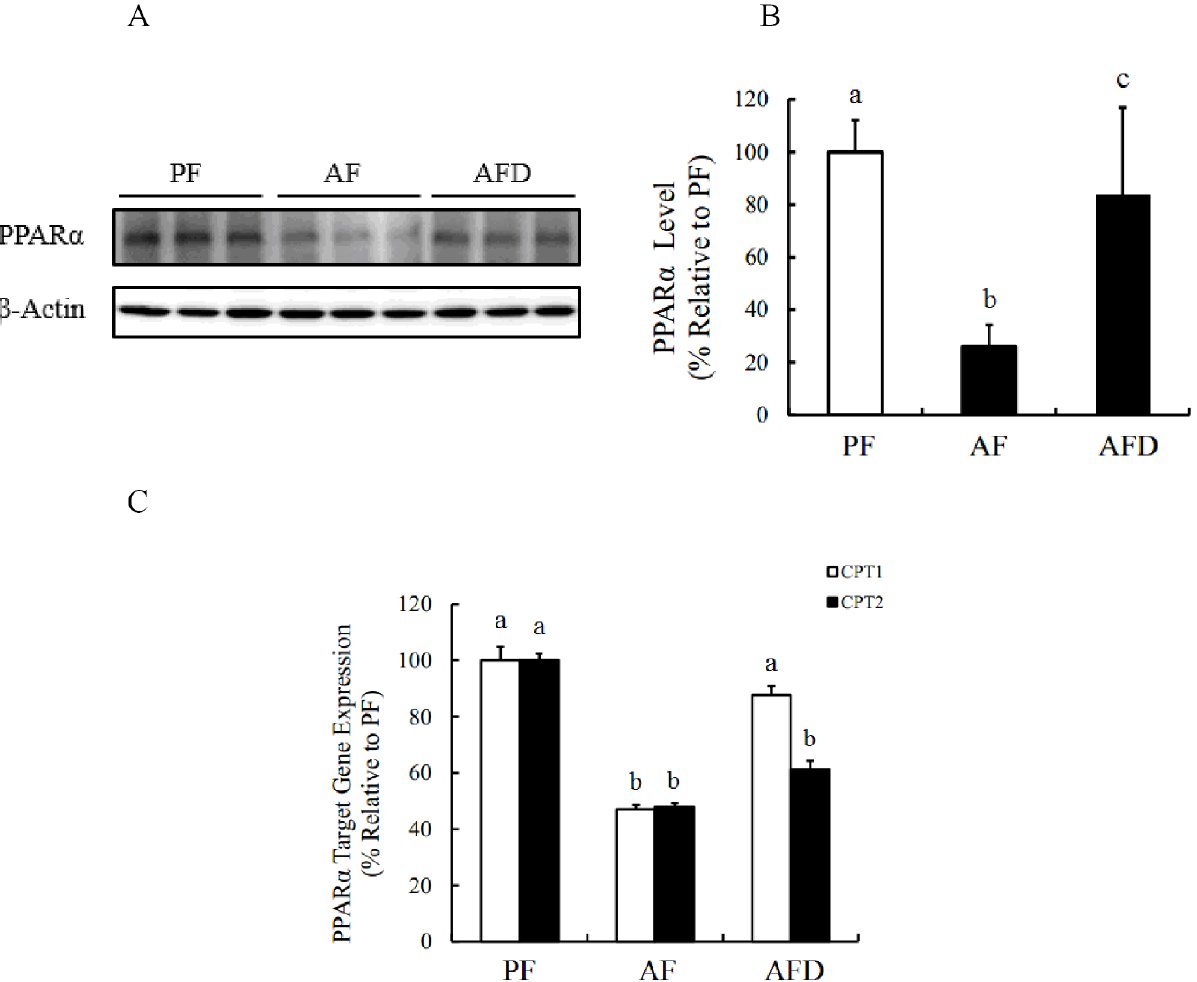
Fig 3. Danshen prevents long-term alcohol exposure induced deactivation of PPAR α in mice. A . PPAR α protein expression levels in liver tissue extracts of mice were measured by Western Blotting. B . The level of PPAR α . C . Gene expressionlevels of CPT-1 and CPT-2 in different groupsof mice. Data are expressed as the mean ± SD (n = 8 mice per group). Bars with different letters differ significantly (p < 0.05). PF: pair feeding; AF: alcoholfeeding;AFD: alcoholfeedingwith Dansheninjection.